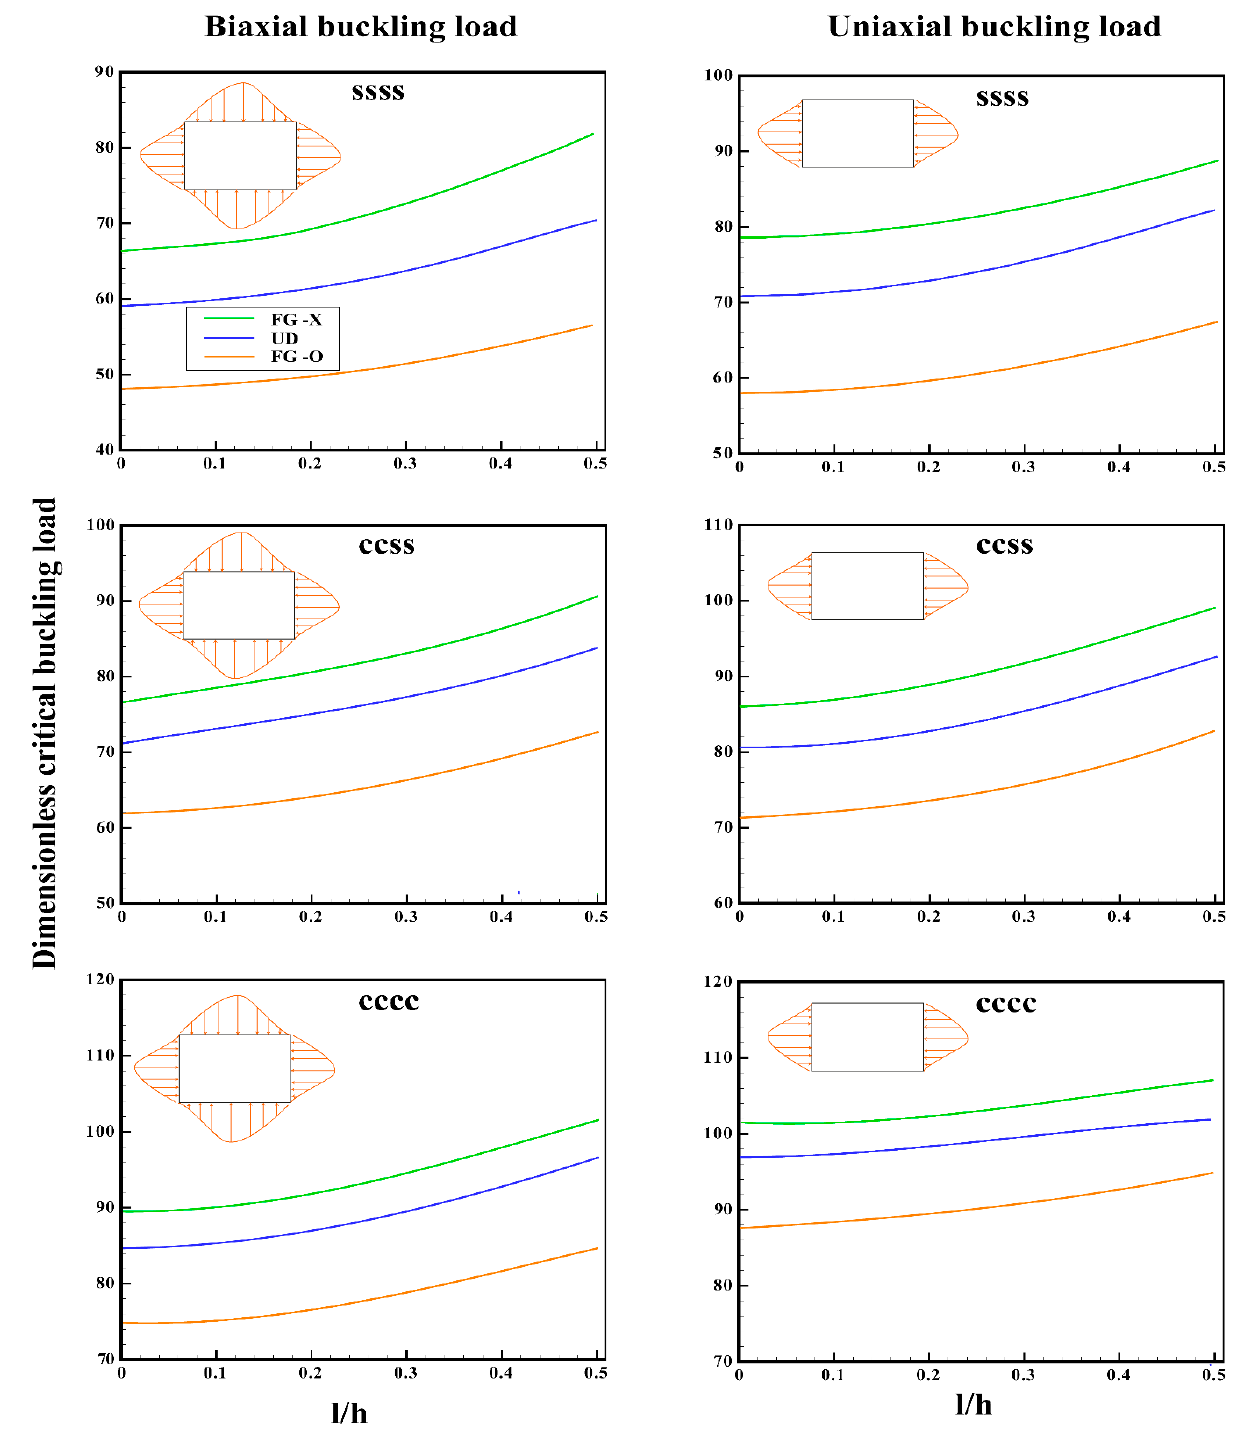
Figure 7. The effects of the CNT distributions on the uniaxial and biaxial buckling loads of the FG-CNTRC microplate against the material length scale parameter to thickness ratio (sinusoidal edge compressive load).